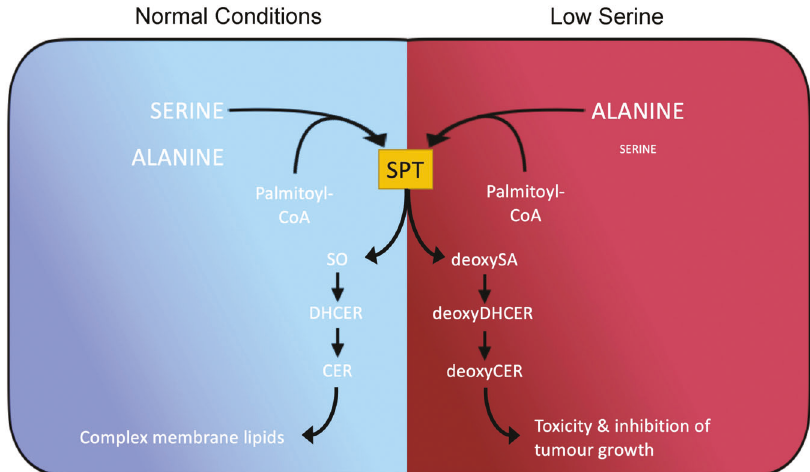
Fig. 1 SPT promiscuity links intra-tumoral serine and alanine metabolism to sphingolipid heterogeneity in cancer cells. Schematic diagram depicting sphingolipid synthesis under normal (left, blue) and low serine (red, right) conditions. Under normal conditions serine palmitoyltransferase (SPT) synthesises sphingosine (SO) as the canonical precursor of dihydroceramide (DHCER), ceramide (CER) and ultimately complex membrane lipids. Under low serine conditions alanine is an SPT substrate, fuelling synthesis of 1-deoxysphinganine (deoxySA), which is further metabolised into 1-deoxydihydroceramide (deoxyDHCER) and 1-deoxyceramide (deoxyCER), altering membrane lipid diversity and impairing tumour